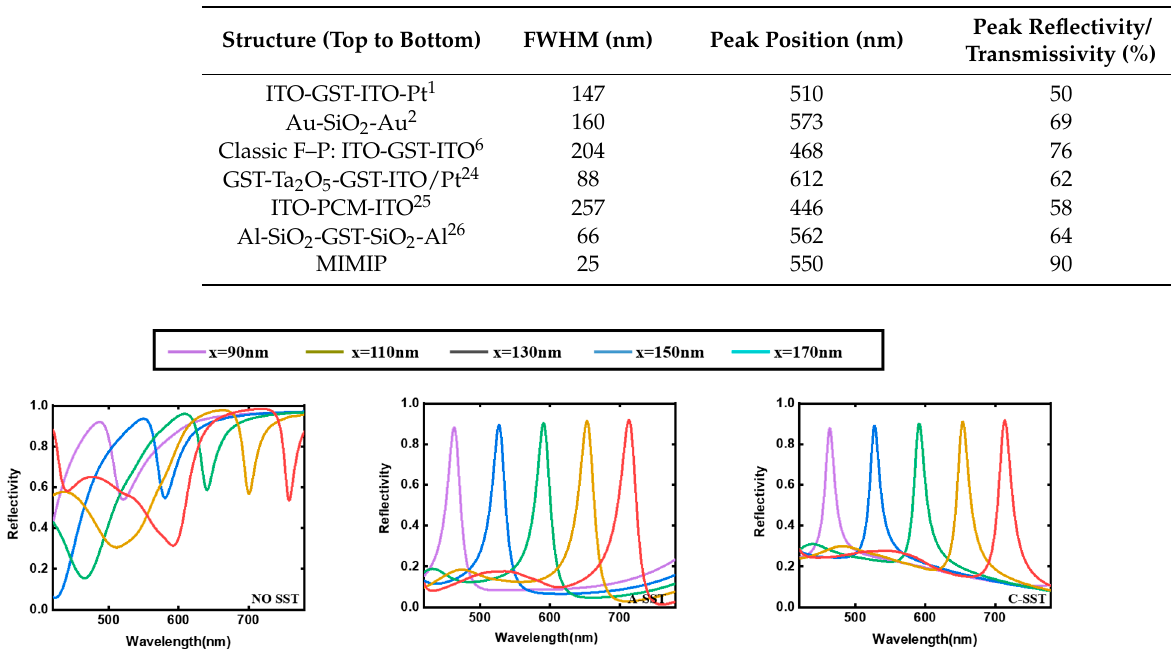
6 of 16 Table 2. Spectral properties of different structures. Structure (Top to Bottom) FWHM (nm)